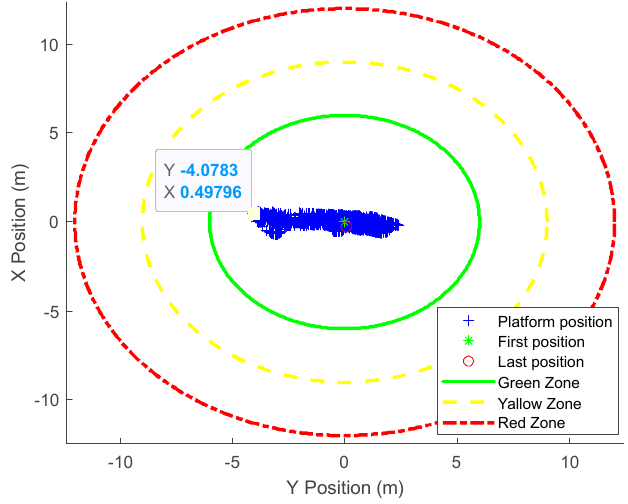
Figure 19. DP simulation with PID control showing platform position (Beam sea).